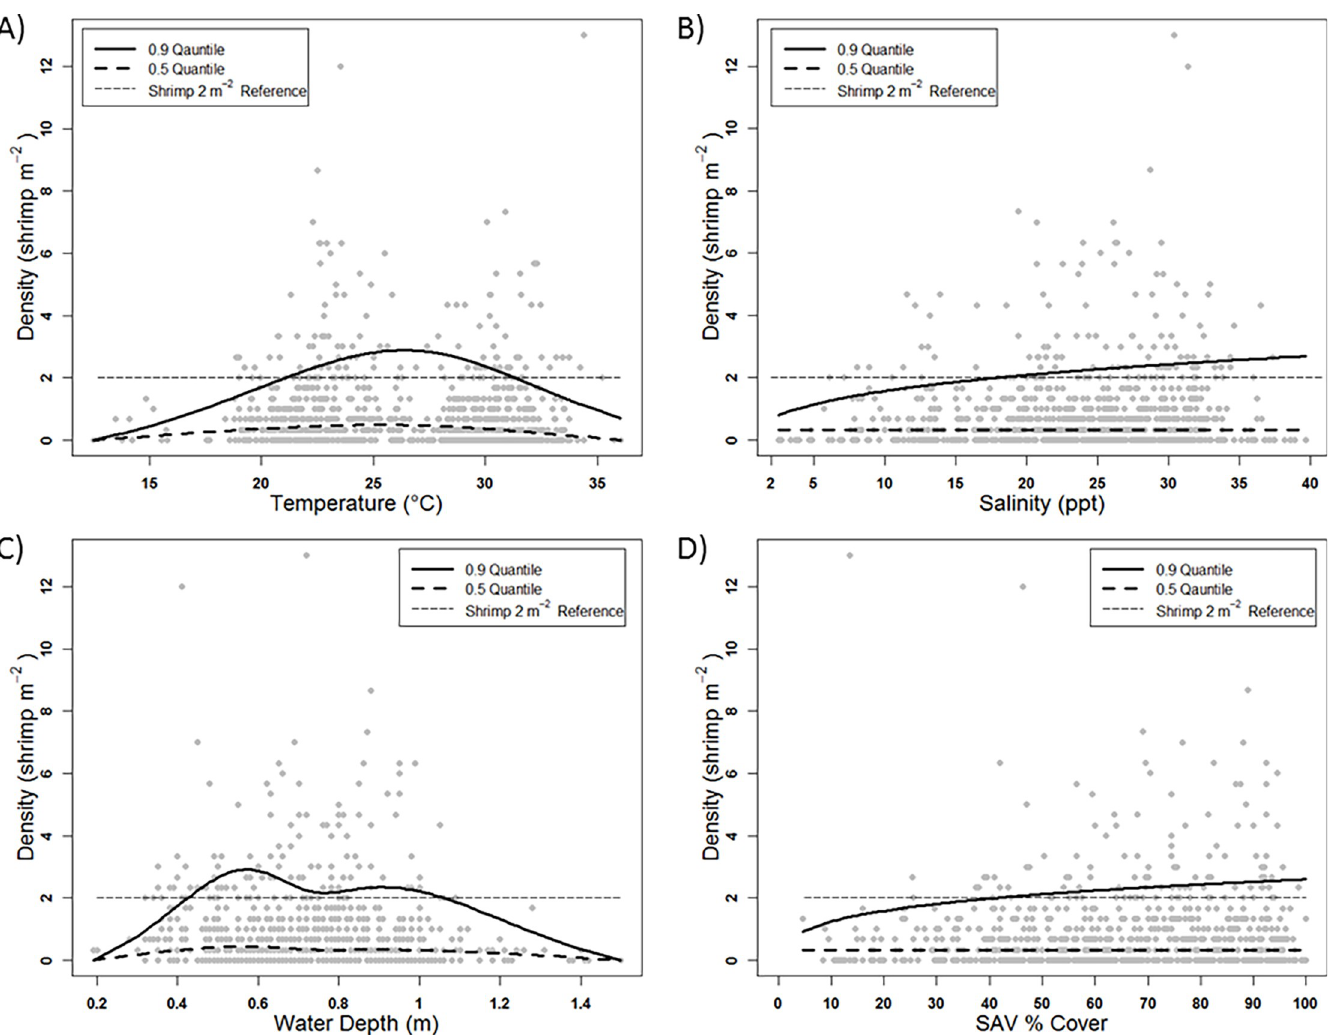
Fig 2. Pink shrimp density (shrimp m -2 ) and back-transformed 0.50 and 0.90 quantile regressions lines of predicted density (LN x+1) plotted against A) temperature (˚C), B) salinity (ppt), C) water depth (m), and D) submerged aquatic vegetation (SAV: % cover). Predicted regression lines depict relationships reported in Table